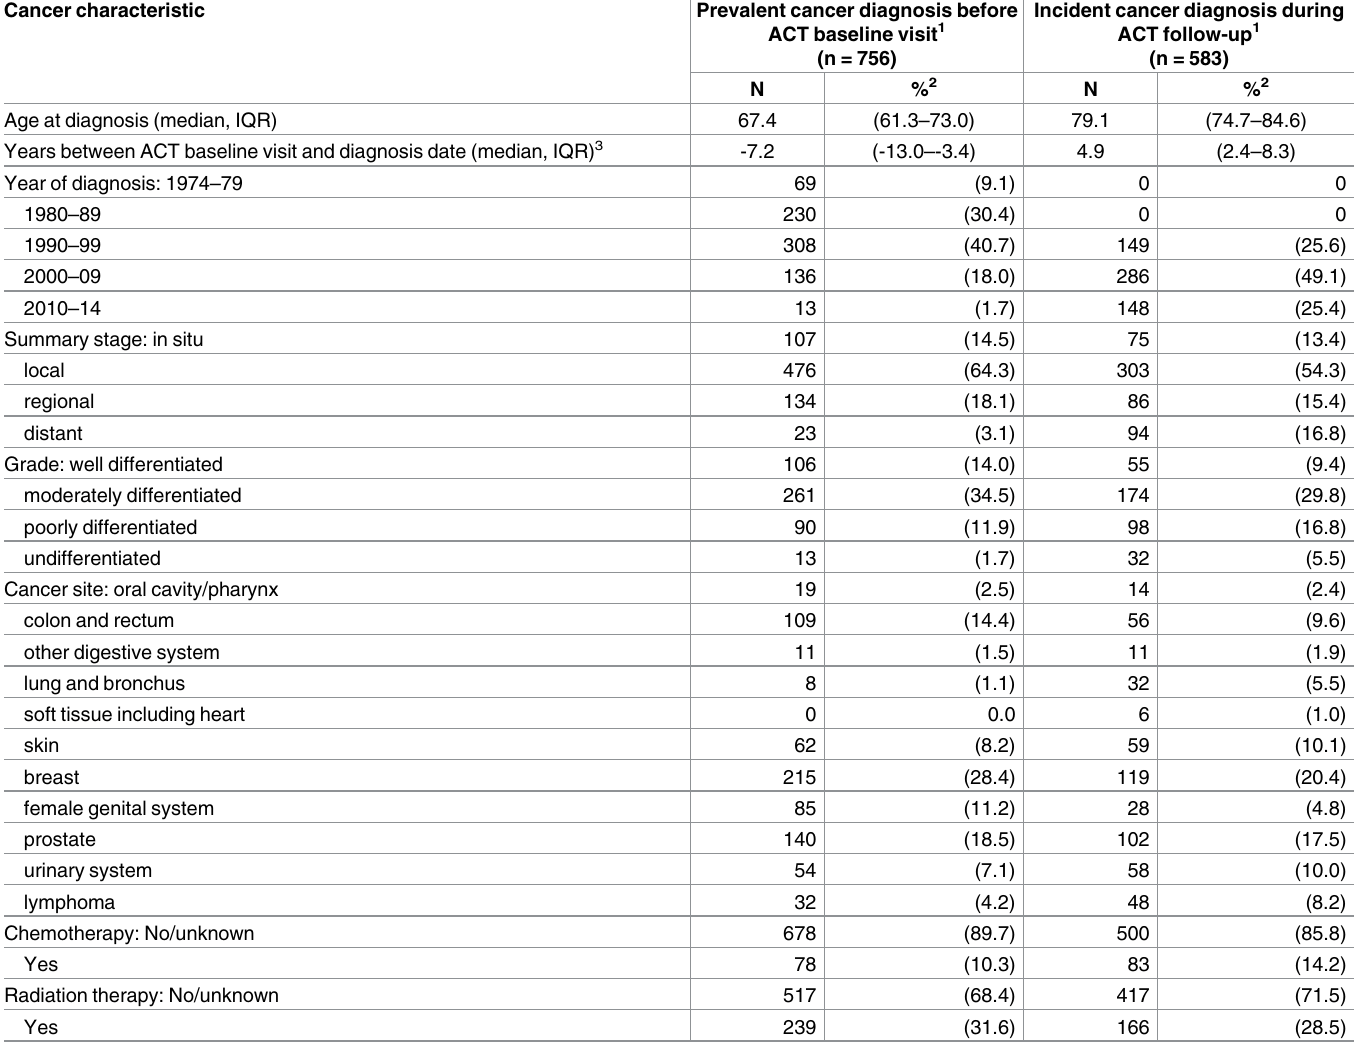
Table 2. Characteristics of cancersdiagnosed before baseline visit and during follow-up in ACT study participants. This table shows the distribu- tions of cancer characteristics amongpeoplediagnosedwith a prevalentor incidentcancer. Abbreviations include:ACT (Adult Changesin Thought) and IQR (interquartile